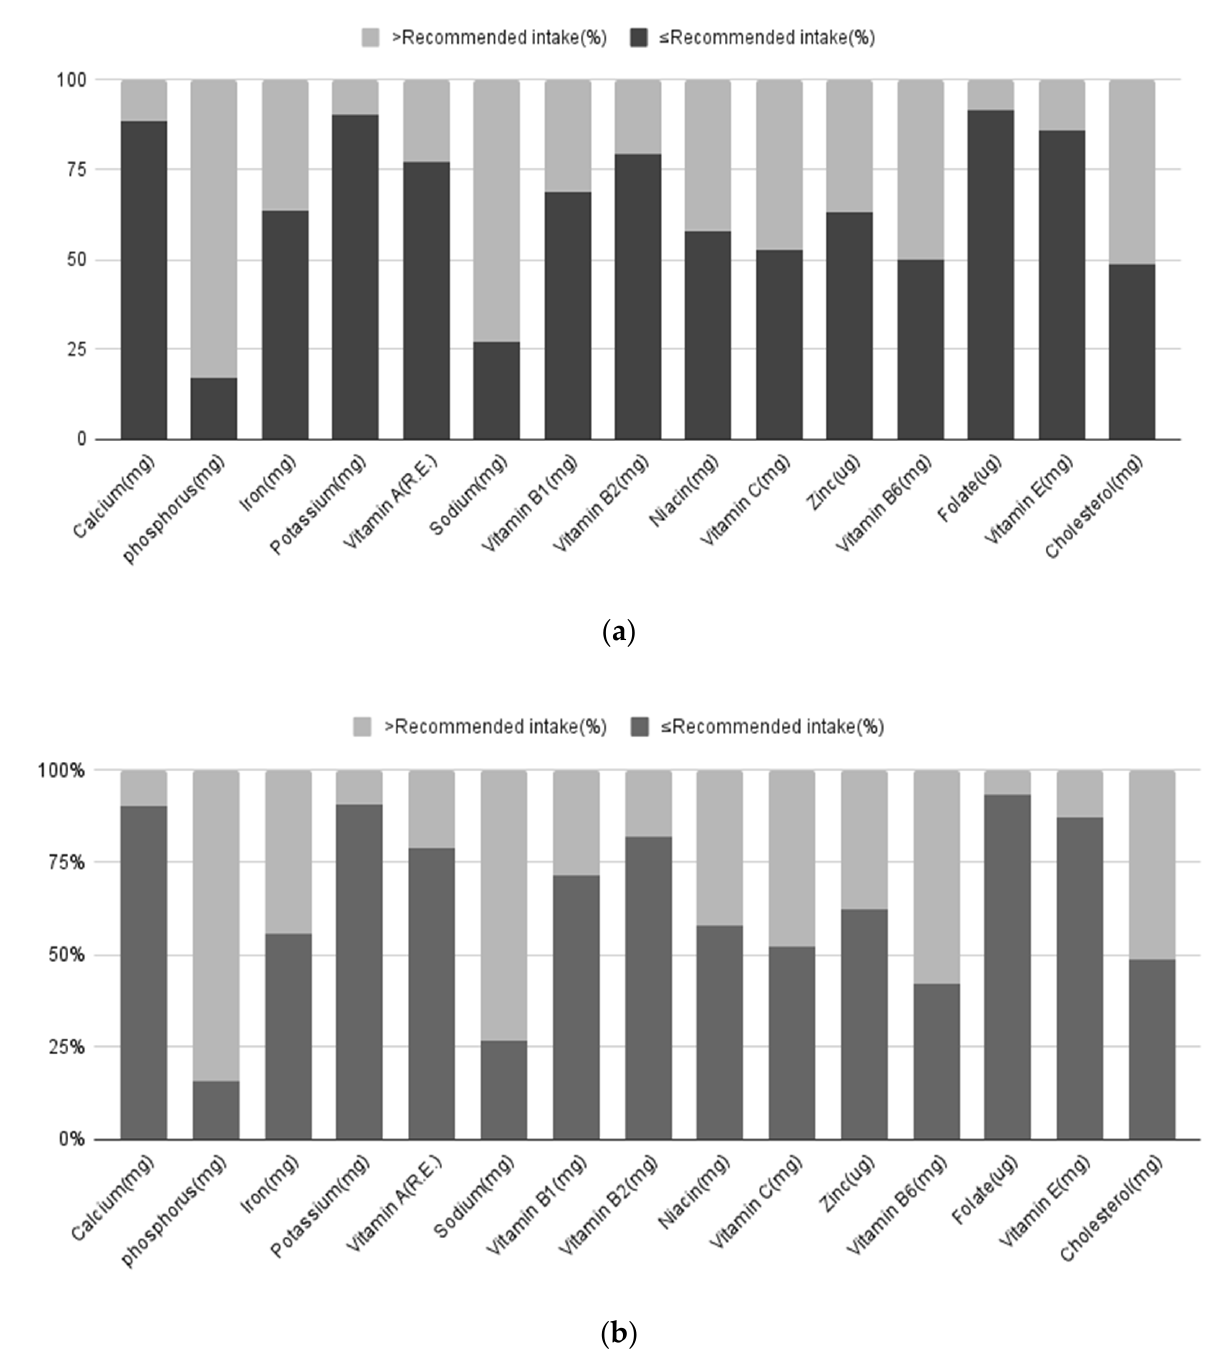
Figure 2. Recommended intake levels of nutrients for breast cancer (%). ( a ) Normal people; ( b ) People with breast